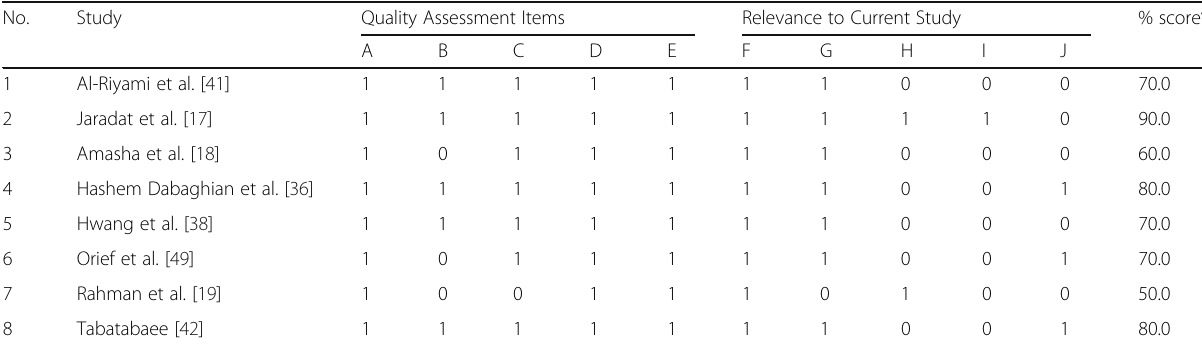
Table 2 Quality Assessment of the Studies No. Study Quality Assessment